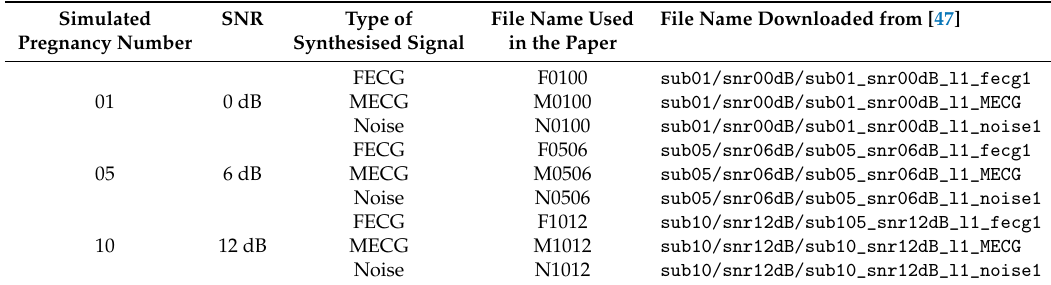
Table 1. Examples of how to rename the files downloaded from the FECGSYNDB large database [47], considering SNR = 0 dB, 6 dB, and 12 dB. The paper file name is used in this paper to shorten the long file name from [47]. Its format is XYYZZ, where X is an abbreviation for the synthesized signal, and is equal to F (for FECG), or M (for MECG), or N (for Noise), YY is the simulated pregnancy number (00-10), ZZ is the SNR (00 dB, or 06 dB, or 12 dB). The ’l1’ code in the downloaded file name refers